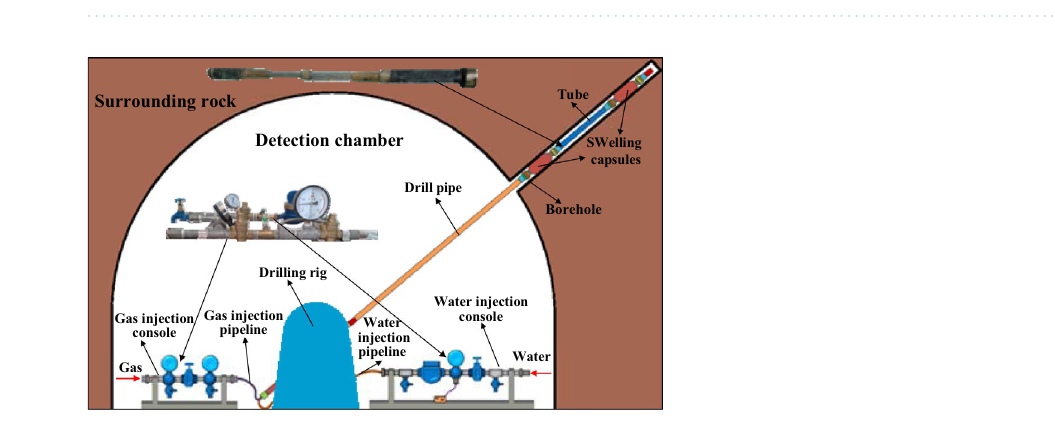
Figure 6. Study site: ( a ) Zhuajiamao mine in Yulin, Shannxi Province, China, and ( b ) Stratigraphic section above the No. 3 coal seam and mining face layout.